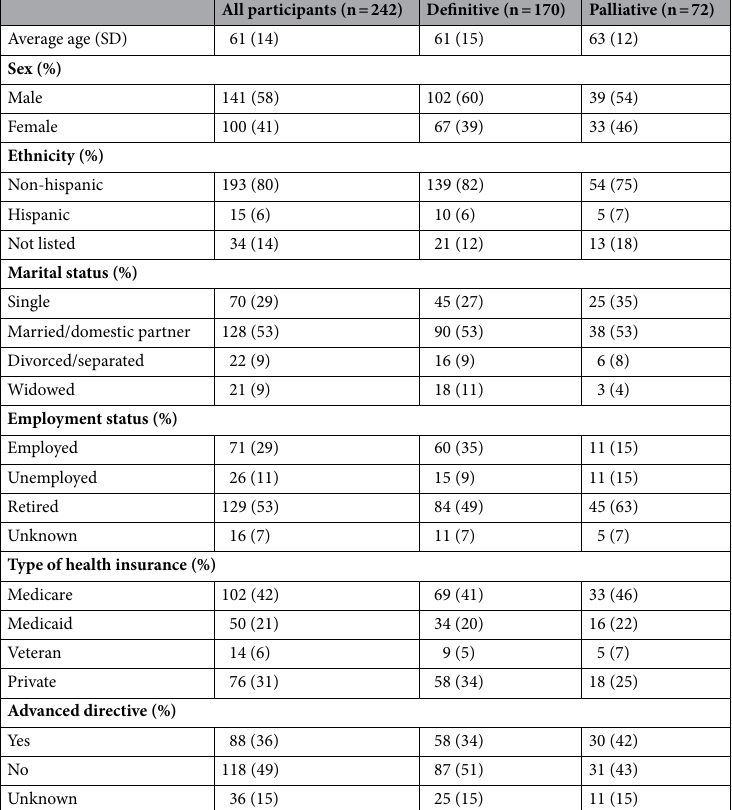
Table 1. Participant demographics. SD standard